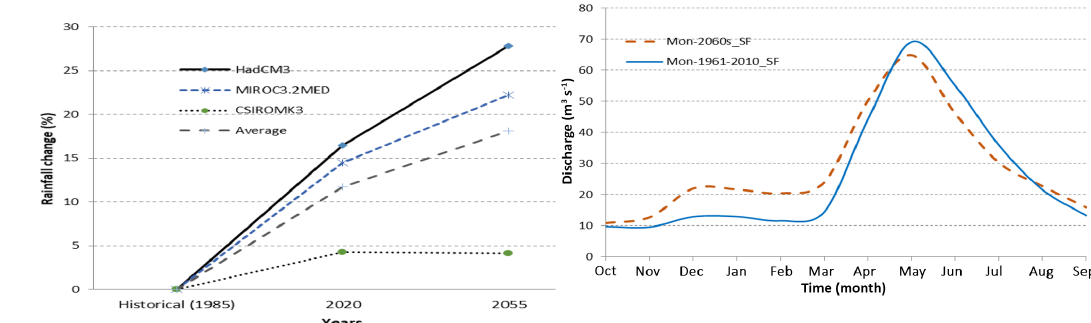
Figure 3. GCM’s delta change and future mean monthly stream flows at IDDC1 in Kikuletwa.